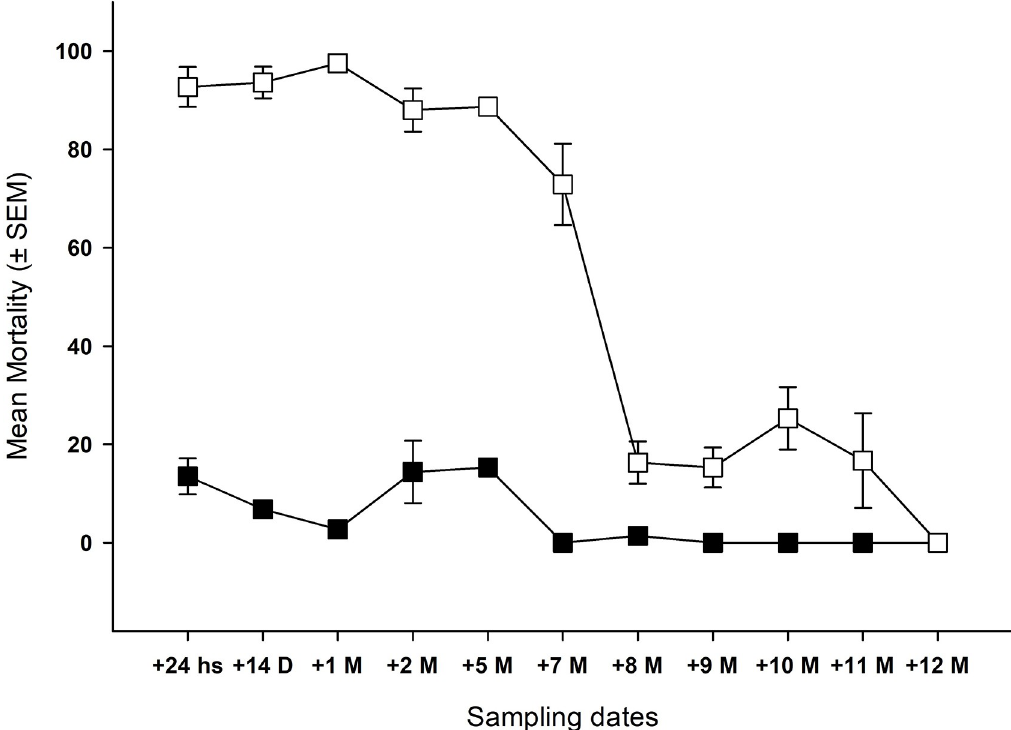
Fig 3. Mortality of pyrethroid-resistant Ae . aegypti (Juan Pablo Strain) by TIRS application method using chlorfenapyr (Sylando 240SC) over time. Mean ( ± the standard error of the mean, SEM) of acute (24-h) corrected mortality (Abbott, 1925) of pyrethroid resistant Ae . aegypti (Juan Pablo strain) by TIRS using Sylando 240SC formulation 250 mg a.i./m 2 (white squares) compared to a control treated with water (black squares).